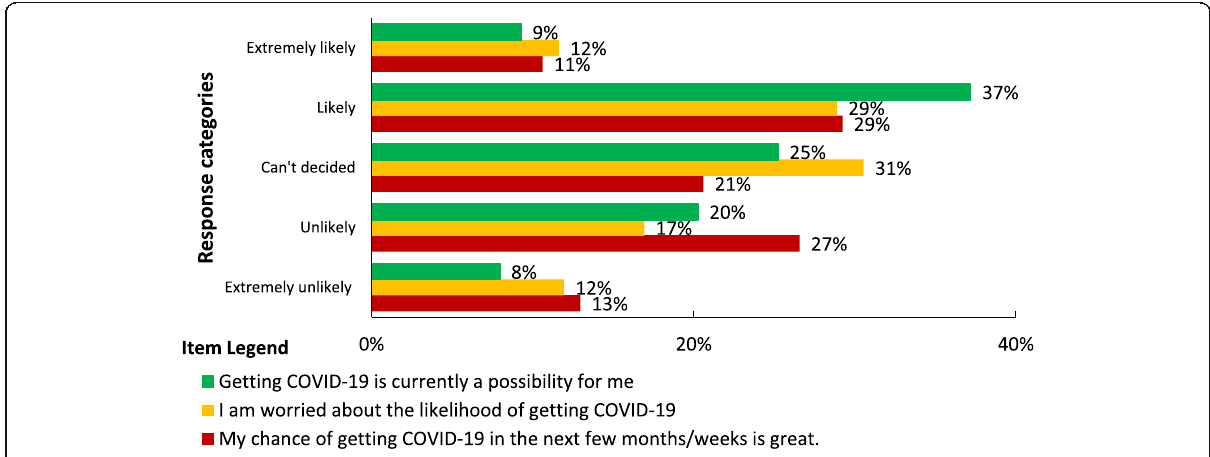
Fig. 2 Perceived susceptibility for COVID-19 among school teachers in Gondar city, Northwest Ethiopia (n =